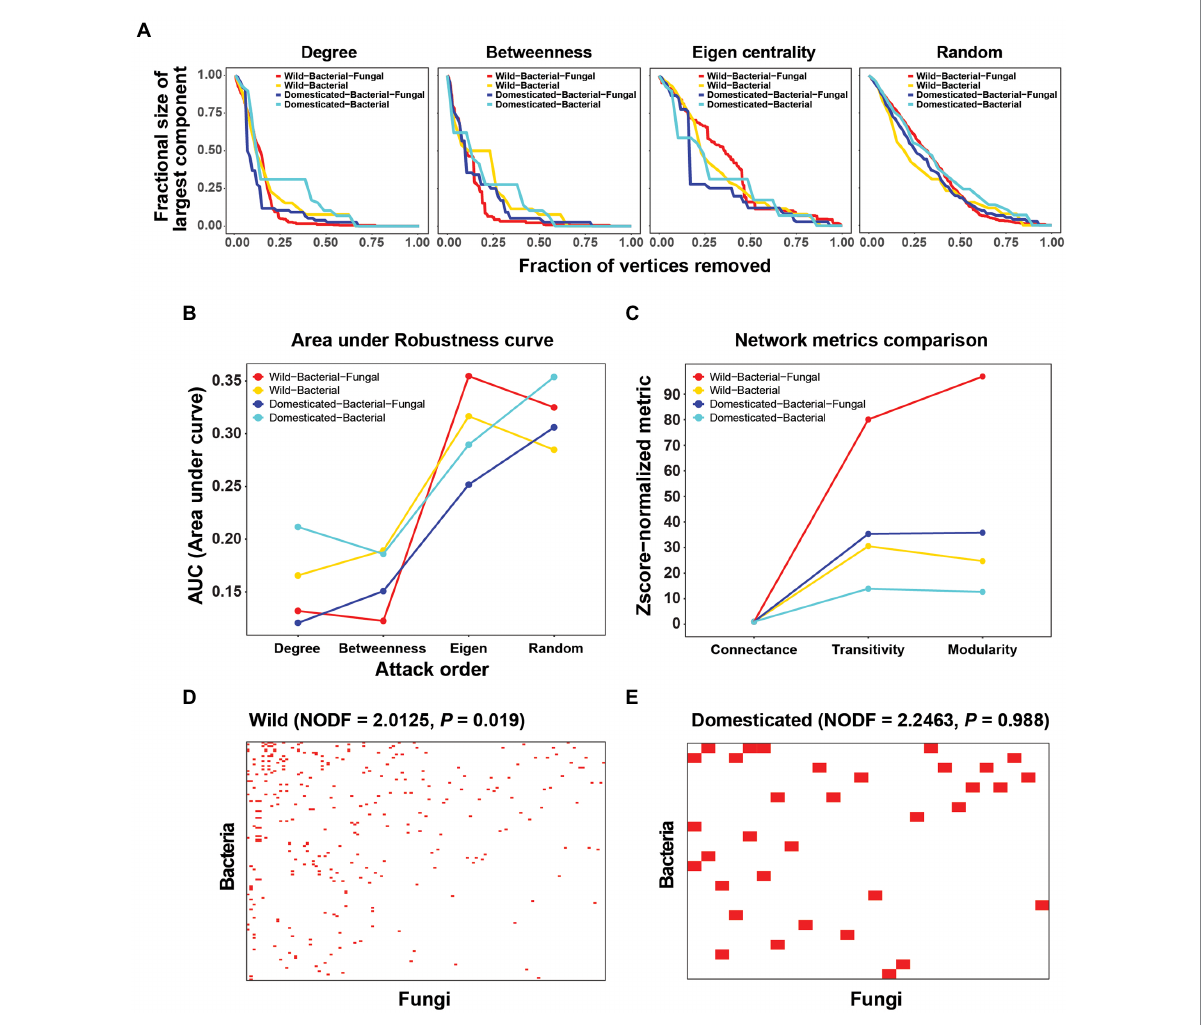
FIGURE 2 Robustness analysis and connectance, transitivity, modularity, and nestedness of cross-kingdom and bacteria-only networks in wild and domesticated rice seed microbiomes. (A) Robustness analysis by in silico extinction experiments. Nodes were deleted from the network in order of degree, betweenness centrality, and eigenvector centrality, and randomly. The size of the largest component ( y -axis) was recorded after every extinction event until all vertices were removed. For robustness curves, the fraction of nodes extinct and the fraction of the largest component size (largest component size after the attack ÷ largest component size before any extinction) were plotted on the x - and y -axes, respectively. (B) Area under the robustness curves for each attack order and network. (C) Z -score normalized connectance, transitivity, and modularity. Z -score normalization of summary statistics was carried out using the mean and SD of random configuration models (with the curveball method). Because the connectance of the random model had a standard deviation of 0, Z -score normalization was done by dividing by the mean of the random model. (D,E) Visualization of nestedness in wild and domesticated cross-kingdom co-occurrence networks. Rows are bacterial species and columns are fungal species. A red pixel denotes a link between bacterial and fungal species. Only edges connecting bacterial and fungal species were used to create the bipartite